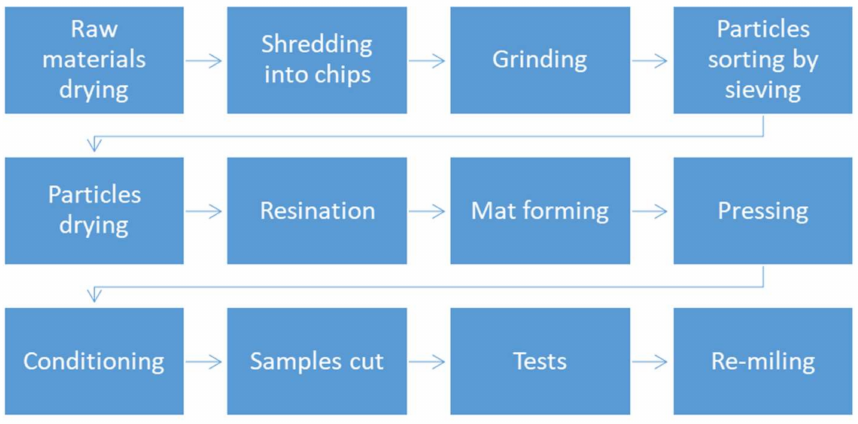
Figure 1. The process of material flow and samples preparation